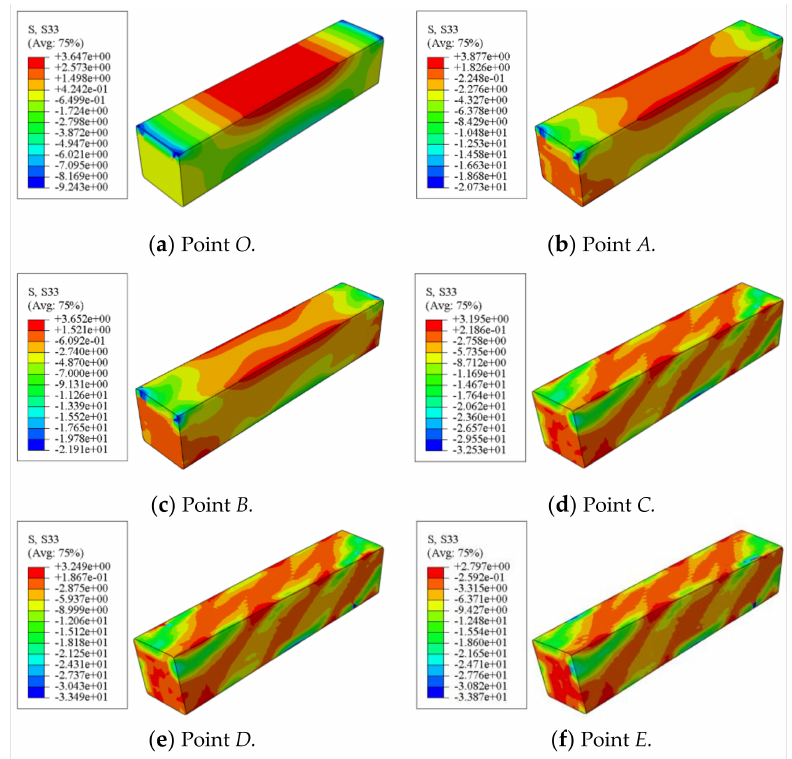
Figure 16. Longitudinal stress distribution of